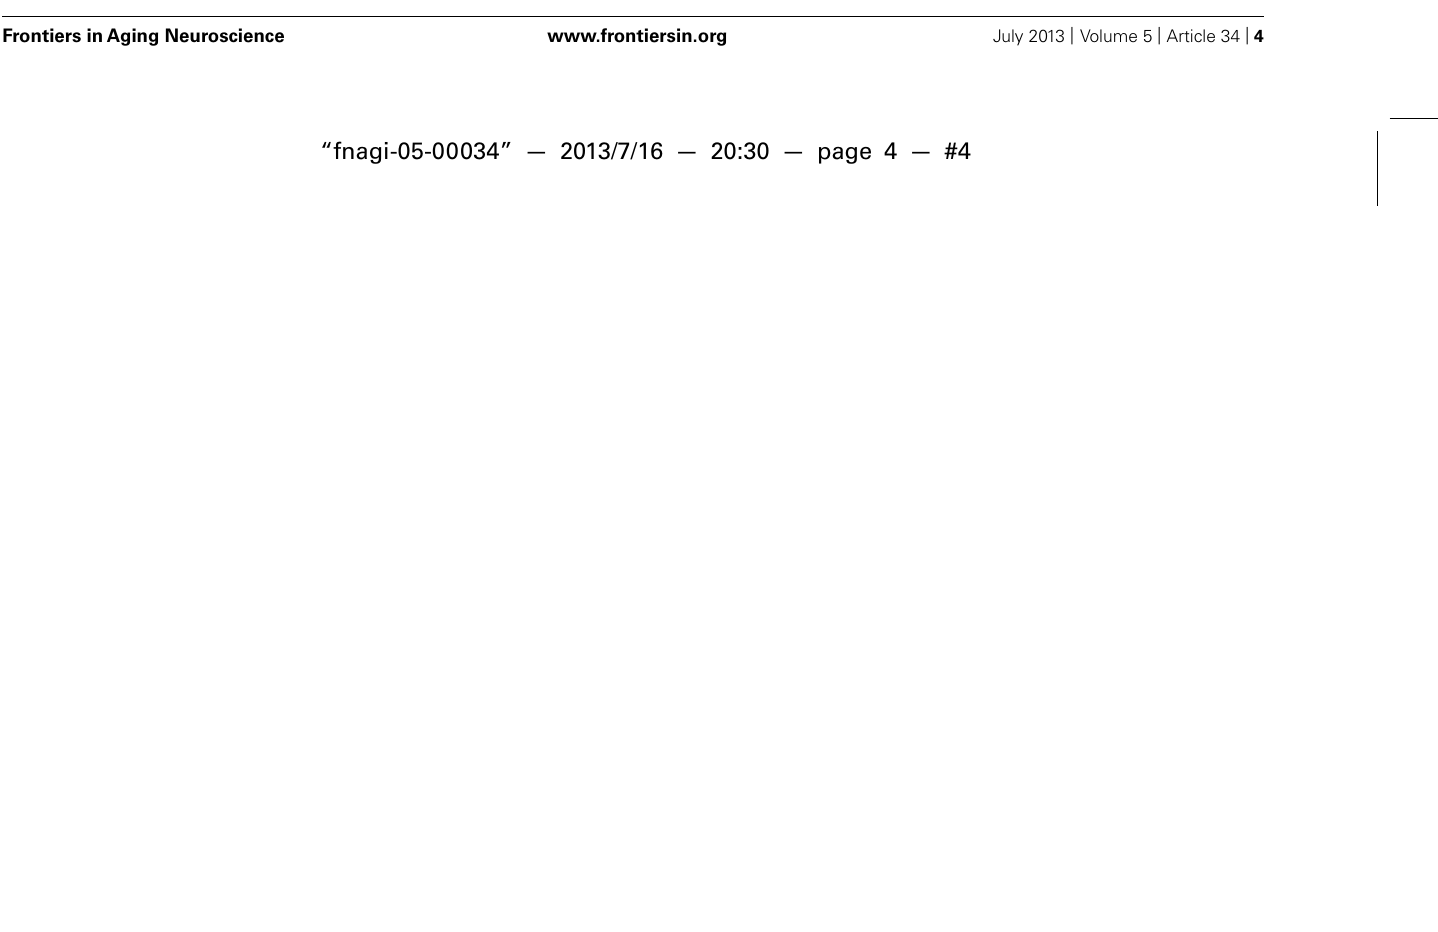
heterodimer with HIF-1 β , activating transcription of target genes possessing hypoxia response elements. In the cytosol, the iron replete cell prevents the binding of iron responsive proteins (IRP) -1 and -2 to the iron responsive elements (IREs) in the 5 (cid:2) and 3 (cid:2) untranslated region (UTR) of mRNA, inhibiting the transcription of uptake proteins and promoting expression of proteins involved in iron export. In cases of iron deficiency, IRPs directly interact with the 5 (cid:2) - and 3 (cid:2) -UTRs, eliciting the reverse effect.TfR, transferrin receptor; DMT-1, divalent metal transporter-1; APP, amyloid precursor